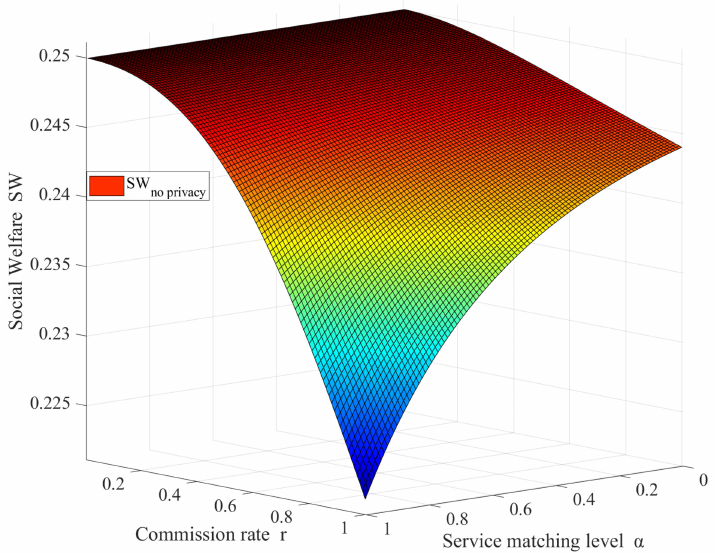
Figure 10. Changes in social welfare when the platform is without consumer data θ . This is obvious from Figure